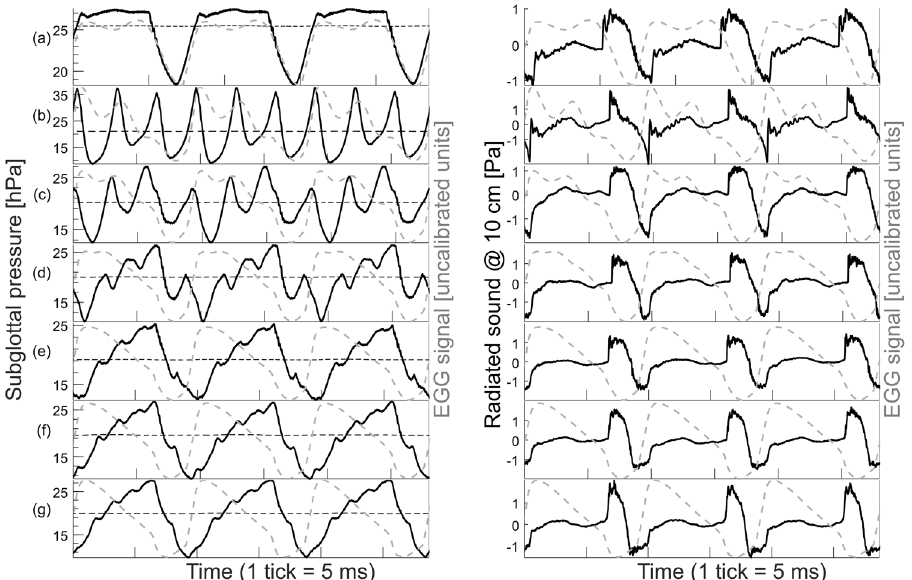
Figure 3. Subglottal pressure (left, solid black lines) and radiated sound (right, solid black lines) waveforms registered with an anechoic subglottal tract and with resonant subglottal tracts set to different resonance conditions: ( a ) anechoic subglottal tract, ( b ) f R1 = 330 Hz, ( c ) f R1 = 400 Hz, ( d ) f R1 = 500 Hz, ( e ) f R1 = 600 Hz, ( f ) f R1 = 700 Hz and ( g ) f R1 = 800 Hz. The horizontal dashed black lines on the left panel indicate the mean subglottal pressure in each case. The waveforms are individually scaled in time (3 cycles are shown). The instants of closure and opening were approximately synchronized using the corresponding EGG signal waveforms (dashed gray lines). Notice the drastic difference in the subglottal pressure waveforms between the anechoic ( a ) and resonant ( b – g ) cases. In ( b – g ), notice the increased frequency of the secondary subglottal oscillations related to the increasing resonance frequency of the subglottal tract. The radiated audio signals also show changes with the different subglottal tract conditions but these are smaller compared to those of the subglottal pressure and occur mainly during the glottal open